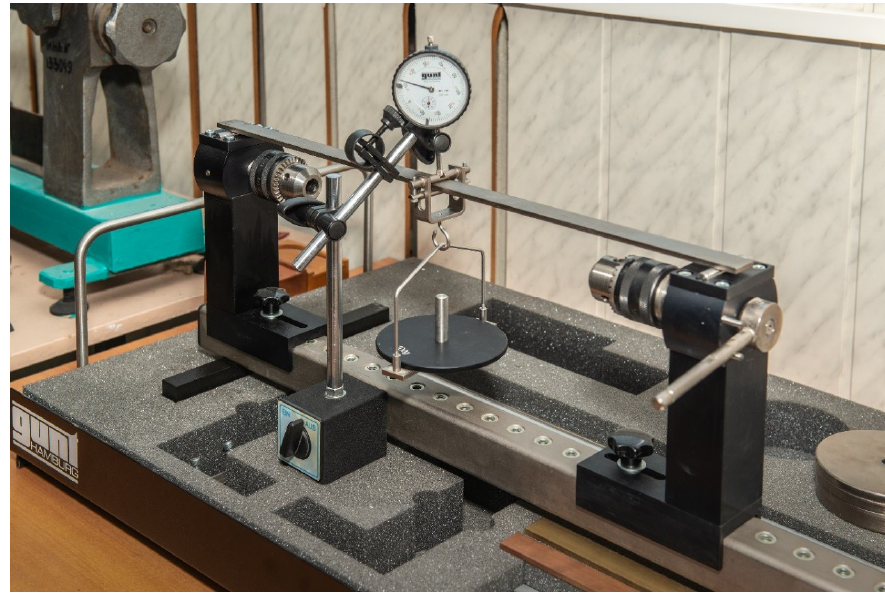
Figure 1. A device for the experimental study of static deformations and displacements of metal beams (G.U.N.T. Gerätebau GmbH, Hamburg, Germany ).